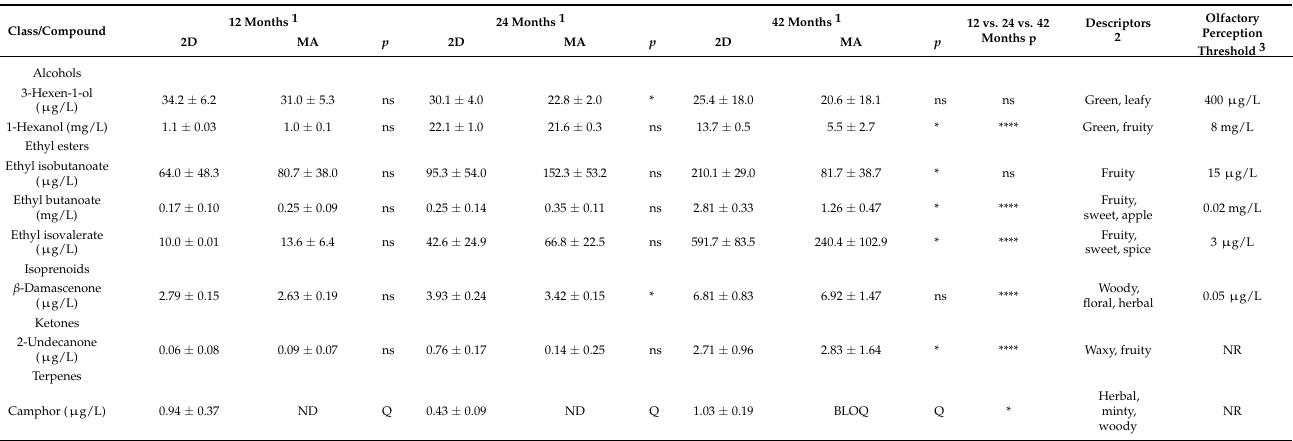
Table 1. Levels of volatile compounds significantly changing in sparkling wine #1 sealed with a sparkling cork with two natural cork discs (2D) and a microagglomerated cork (MA) during bottle aging (12 to 42